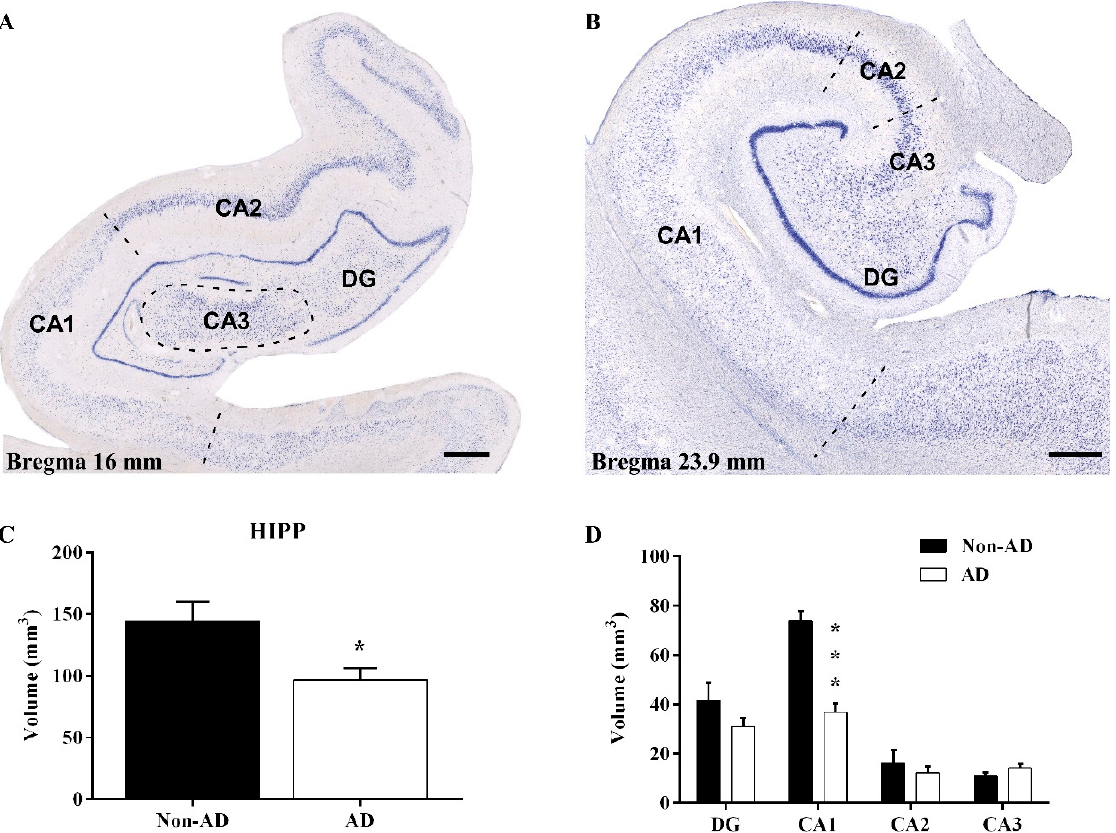
Figure 1. Hippocampal volume reduction is specific to the CA1 subfield. Nissl staining of the AD HIPP at 16 mm ( A ) and 23.9 mm ( B ) from bregma, representing rostral to caudal levels, respectively, and identification of the hippocampal subfields (CA1-3 and the DG). The global HIPP volume ( C ) and volume of the CA1 subfield ( D ) were significantly reduced in AD (the graphs show the volume mean ± SEM, * p value < 0.05, *** p value < 0.001). Scale bar = 1000 µm.